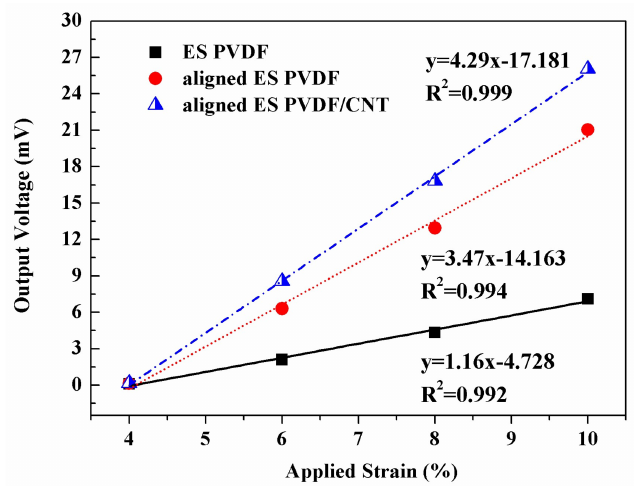
Figure 7. Applied tensile strain vs. output voltage of the piezoelectric PVDF